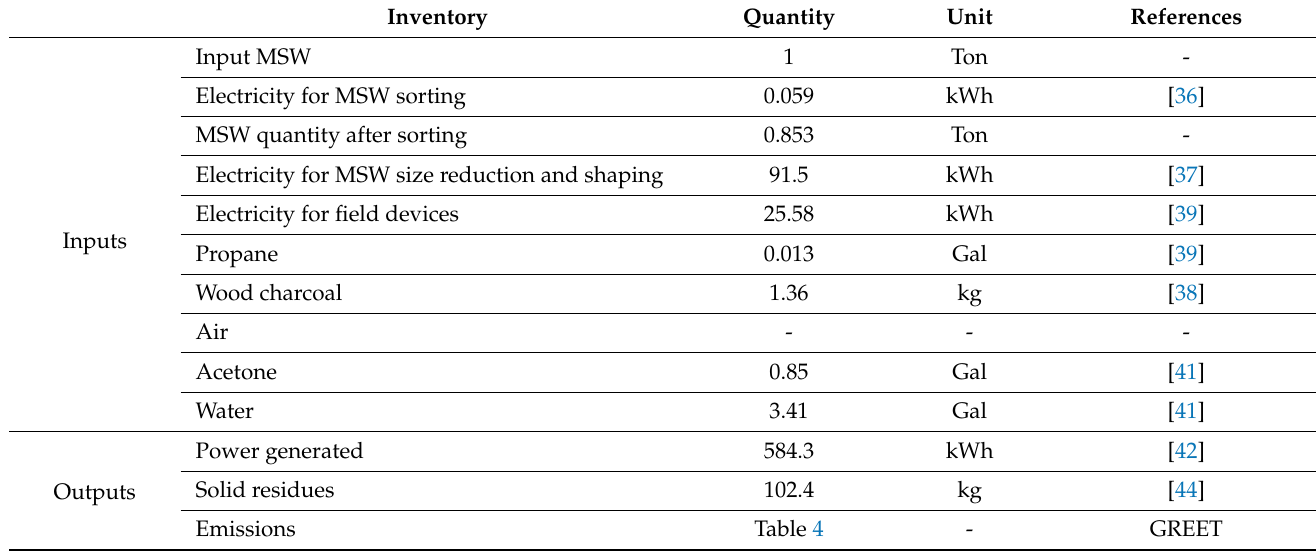
Table 3. LCI of MSW gasification per ton of